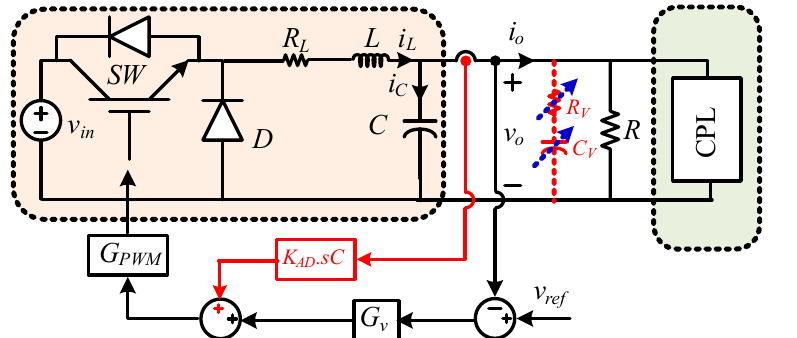
Figure 11. AVRC methods given in [87].